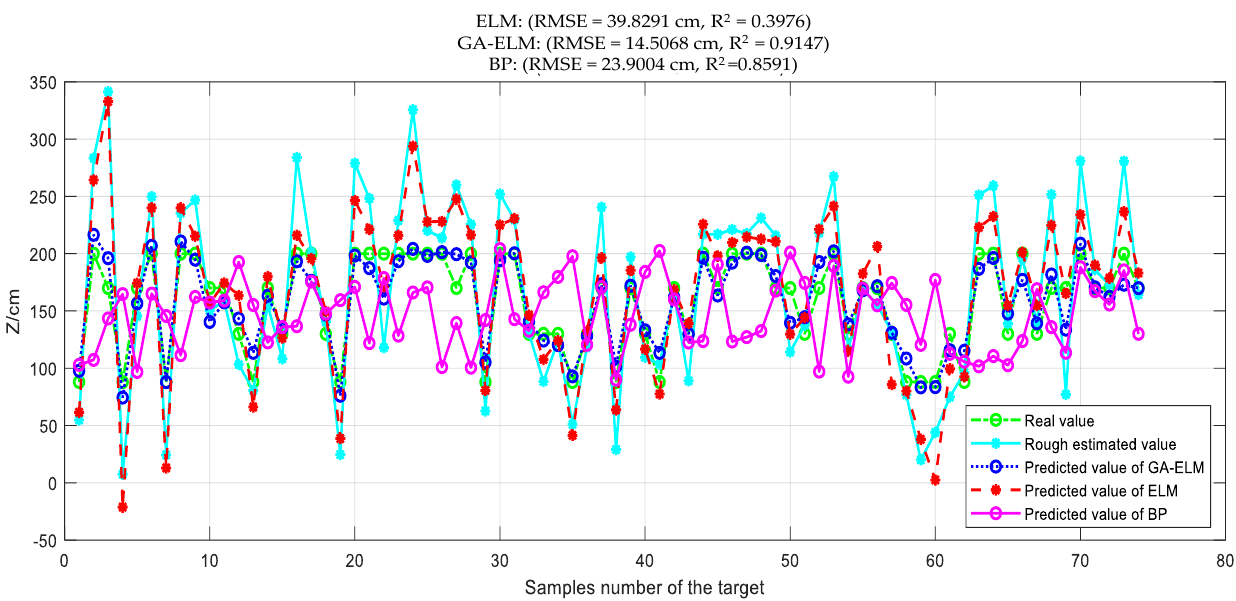
Figure 11. The comparison of the prediction results of the Z -axis errors of the test set target.